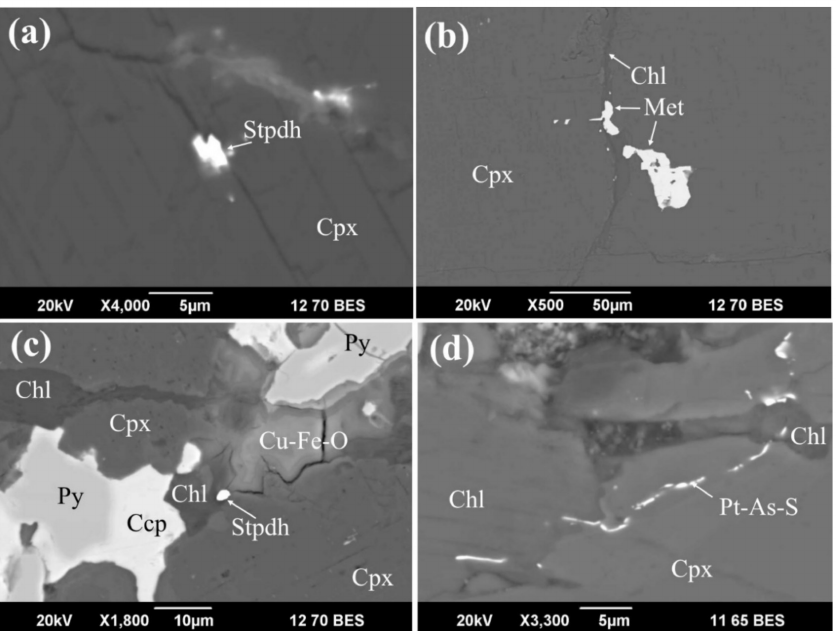
Figure 10. Noble metal minerals in clinopyroxene I. ( a ) Stibiopalladinite (Stpdn) in the cleavage crack in clinopyroxene (Cpx); ( b ) mertieite I (Met) grain in clinopyroxene (Cpx) and chlorite (Chl) veinlet; ( c ) stibiopalladinite (Stpdn) grain enclosed in chlorite. Chlorite is associated with pyrite (Py) and chalcopyrite (Ccp), which are partially replaced by hypergene iron and copper oxides (Fe-Cu-O); ( d ) veinlets of platinum sulfoarsenide (Pt-As-S) cutting clinopyroxene and chlorite.